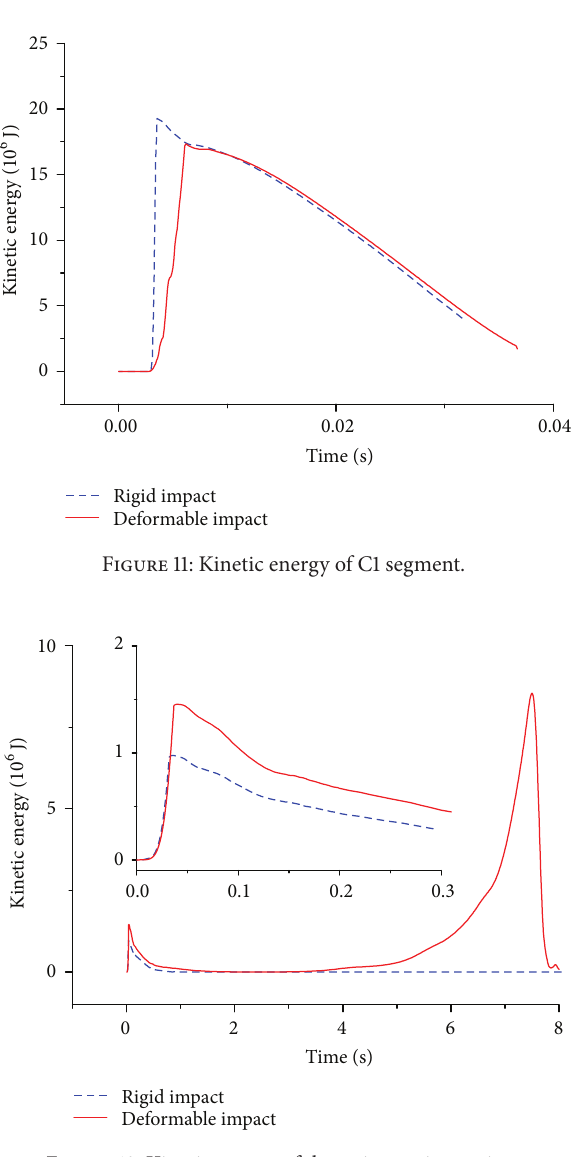
Figure 12: Kinetic energy of the unimpacting